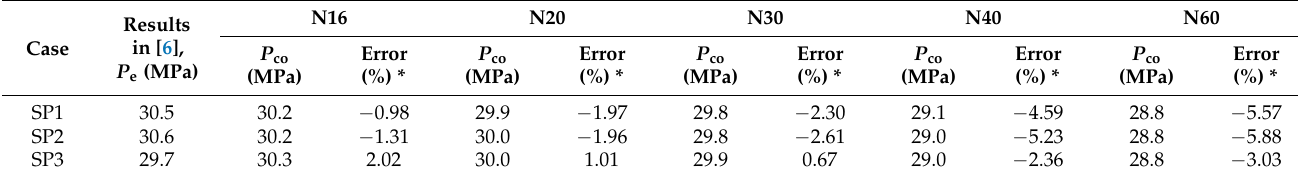
Table 4. Comparison results between calculation and experiment of